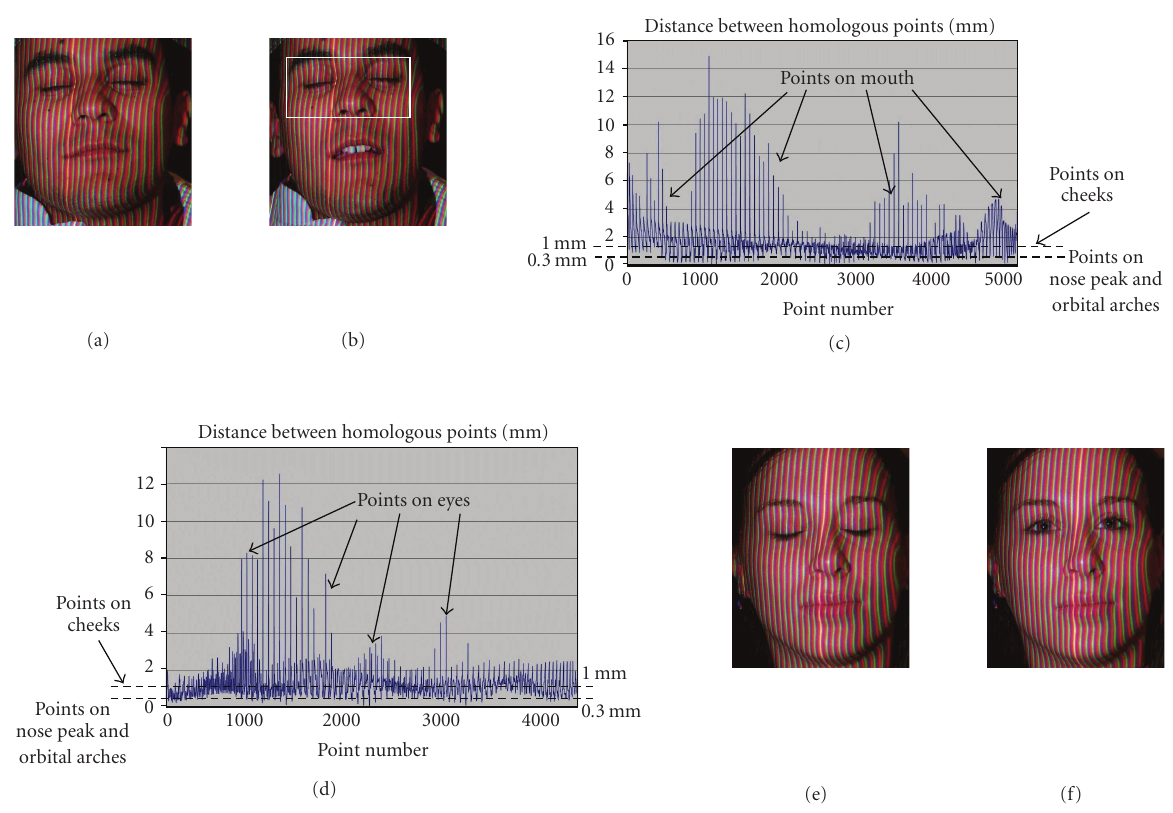
Figure 7: Registration results for humans. (a) Man with closed eyes and mouth. (b) Man with closed eyes and open mouth. The window in (b) indicates the data of the image to be transformed in the first registration test (the whole 3D points are used in the second test). The colour rays are the structured light information used for the 3D point reconstruction. (c) Computed distances between homologous points of (a) and (b) after registration. (d) Computed distances between homologous points of (e) and (f) after registration. (e) Woman with closed eyes and mouth. (f) Woman with open eyes and closed